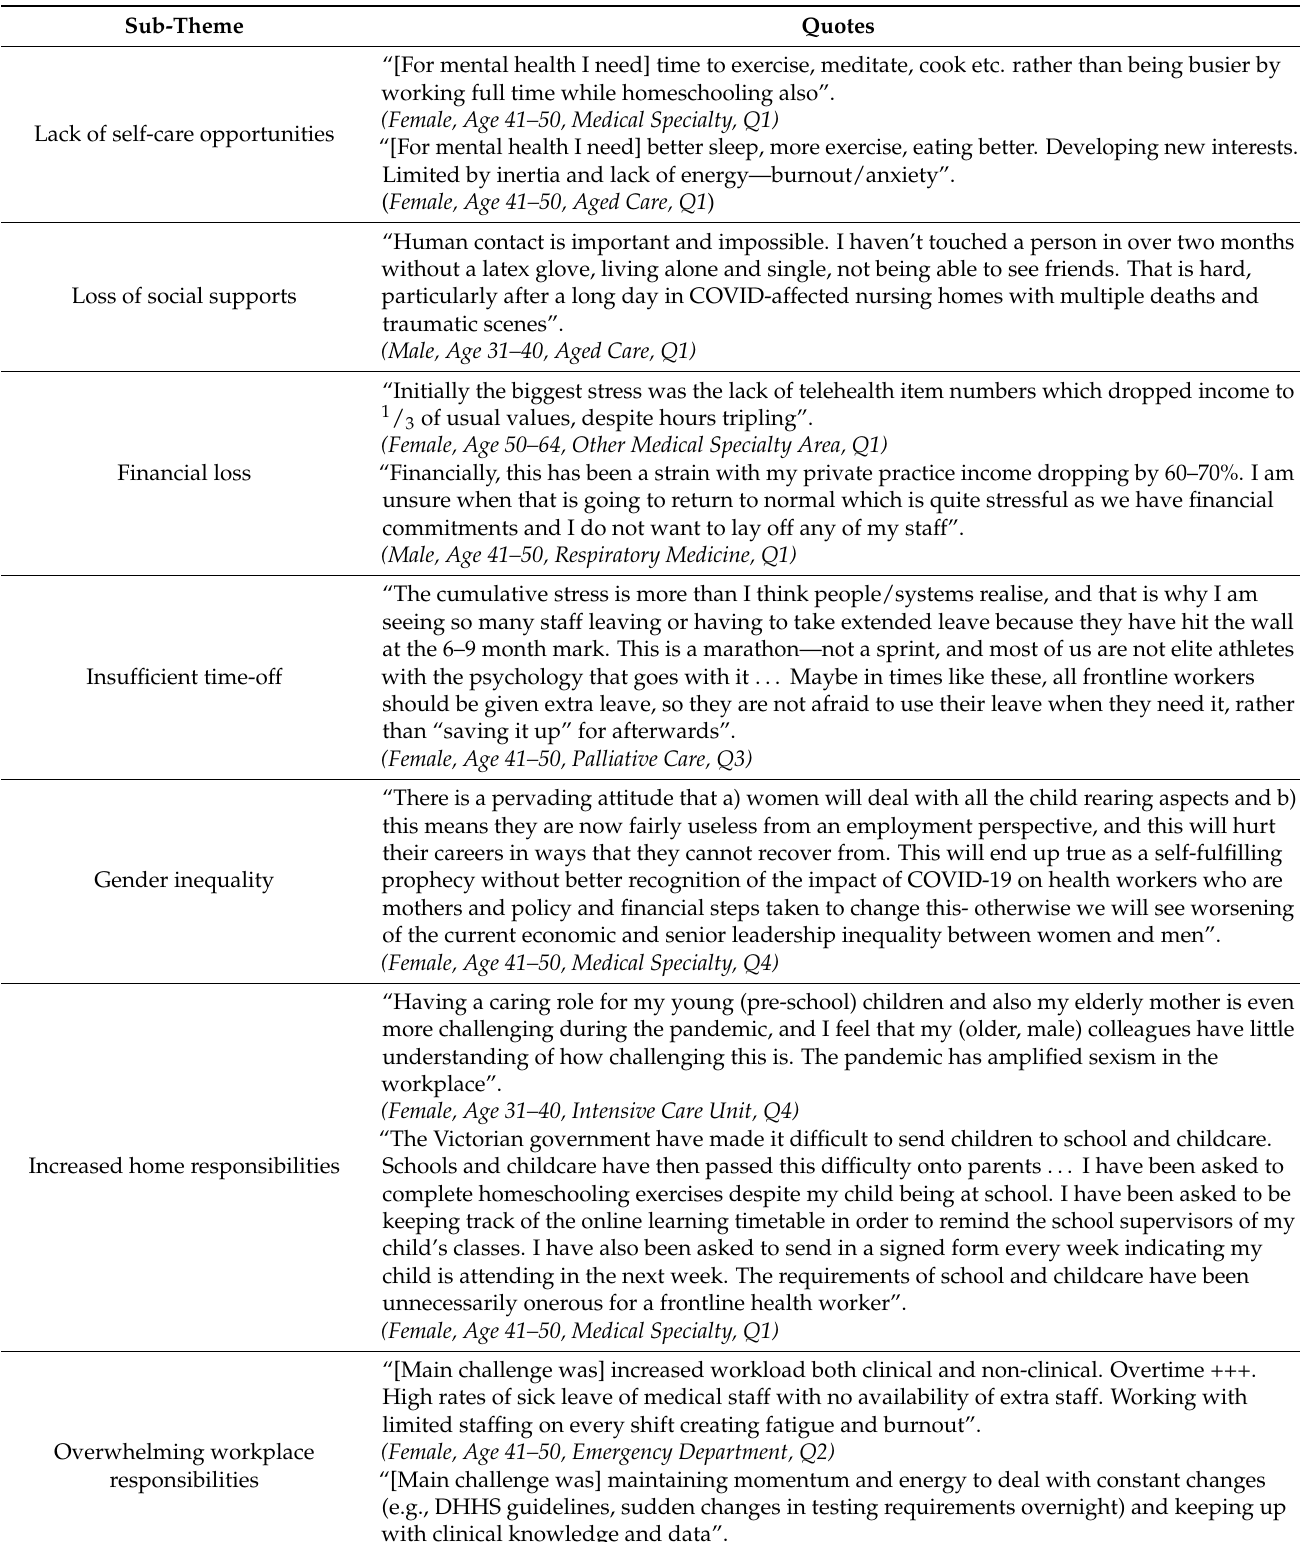
Table 3. Work–life